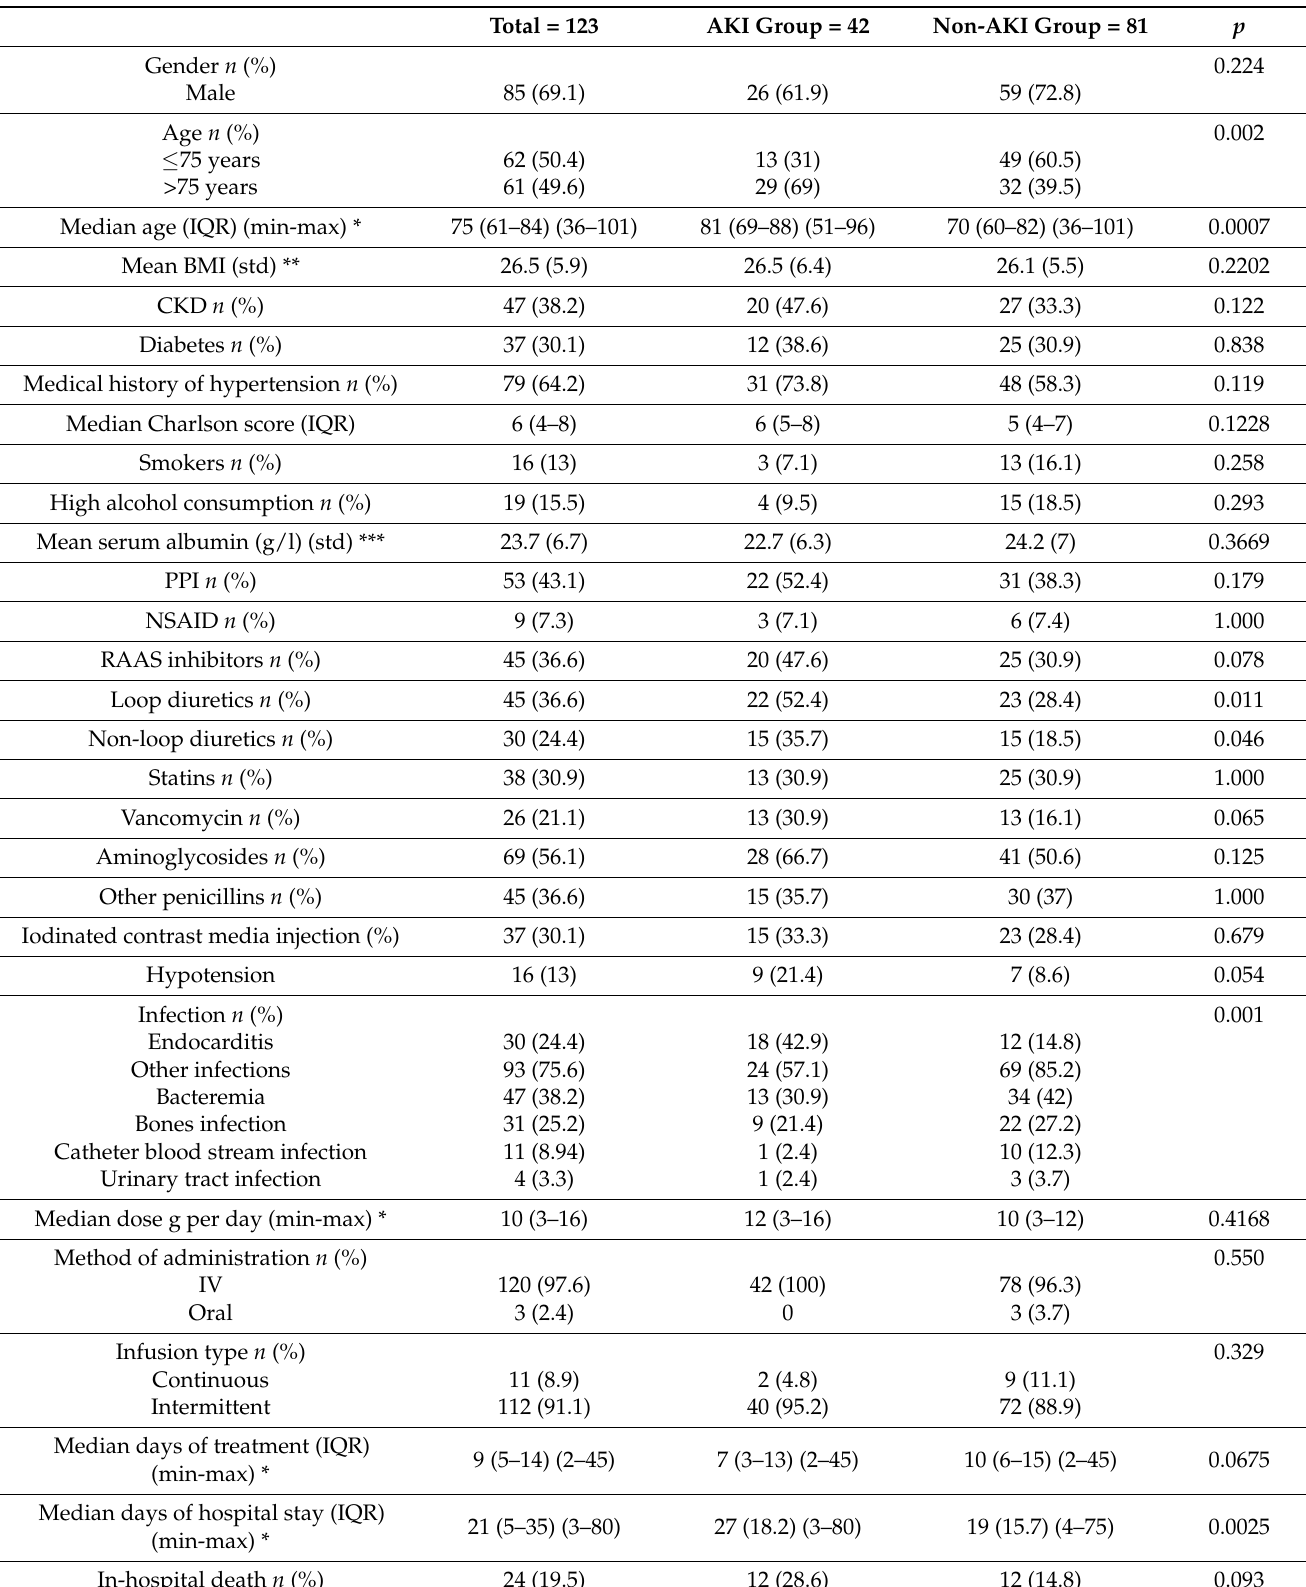
Table 1. Characteristics of patients included in the CLOX-AKI study, CH Le Mans, 1 July 2012 to 1 July